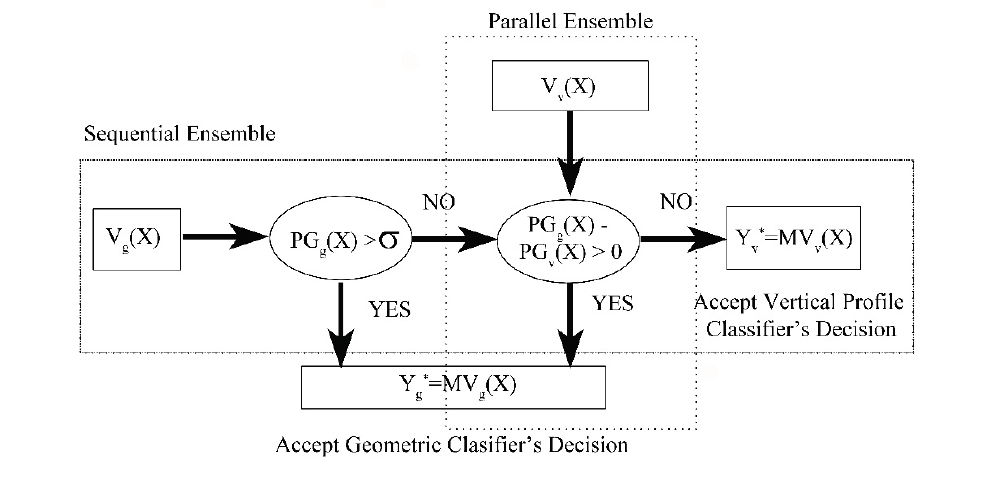
Figure 4. Summary of the ensemble method using the geometric classifier as first classifier: MG g and MG v indicate the margin obtained from the geometric and the vertical profile classifiers, respectively; V g and V v represent the vote proportions obtained from the geometric and vertical profile classifiers, respectively; Y g* and Y v* correspond to the final predictions from geometric and vertical profile classifiers